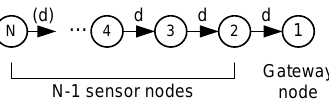
Figure 1. String network with a set of N − 1 equidistant (distance d ) sensor nodes and a single Gateway node (node 1) at the extreme.